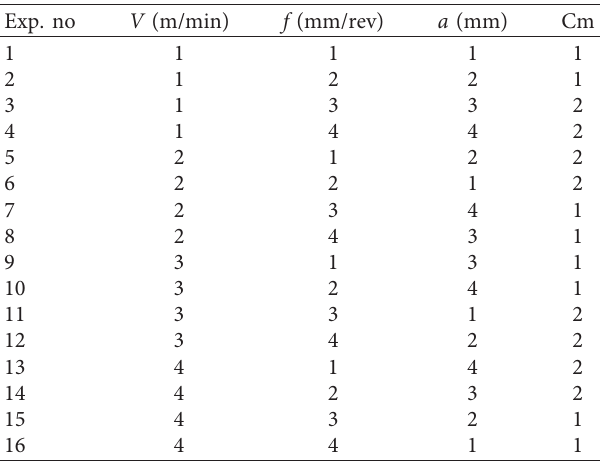
Table 1: Taguchi L 16 experimental design. Parameters Spindle and servo motor energy consumption stems from two sources. The first is the movement of the spindle shaft and workbench and acceleration/deceleration under the influence of inertia, friction resistance, and gravity. The second is the cutting force expended in overcoming cutting resistance [7]. Equation (4) presents the energy consump- tion model P (Wh) representing the machine tool operating mode (positioning and acceleration of the spindle after a tool change/machining/returning of the spindle to tool exchange Table 2: Taguchi L 16 design with orthogonal position after machining/stopping of the spindle).